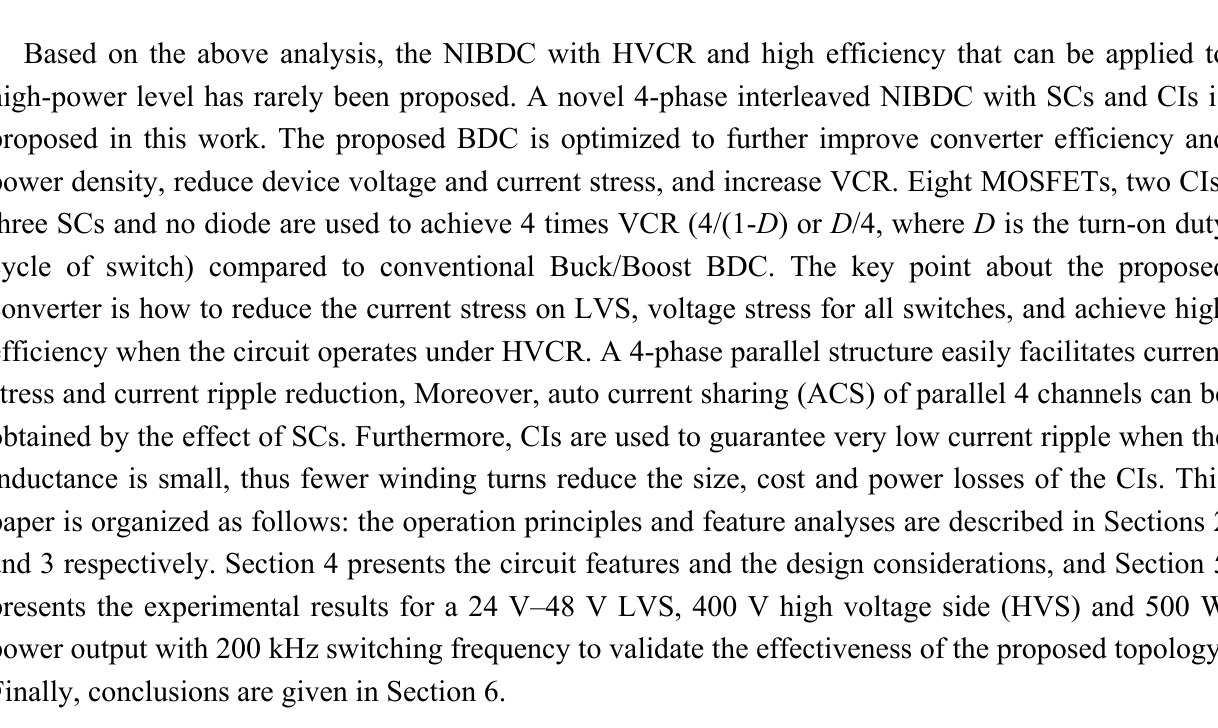
Figure 4. Circuit diagram of the interleaved high step-up soft-switched